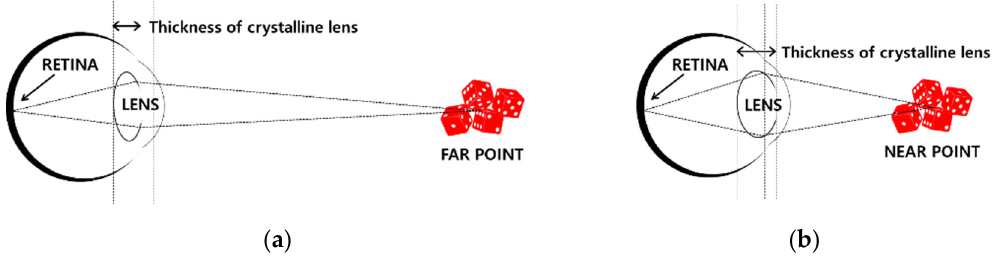
Figure 2. Changing thickness of the lens of the human eye: ( a ) looking at far point; ( b ) looking at near point.